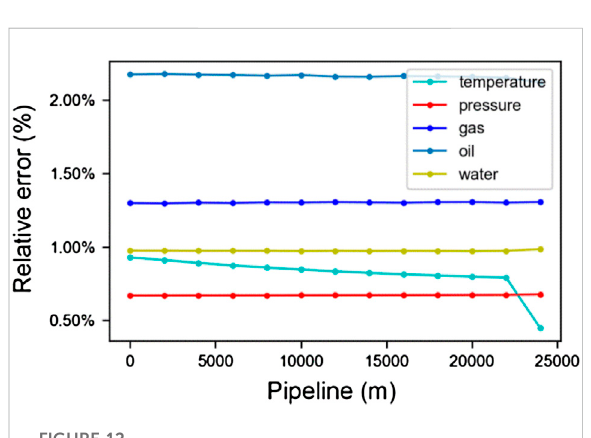
FIGURE 12 The average relative error for all test cases at different